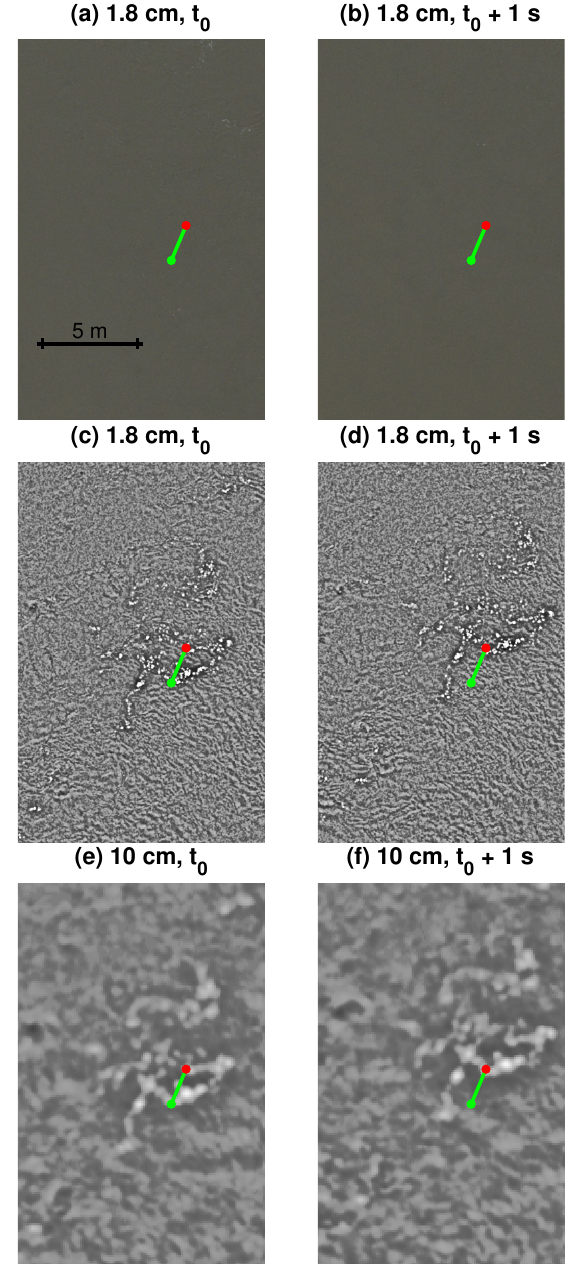
Figure 7. Importance of image preprocessing and spatial resolution. Green point represents location of the tracked feature at time 0 and red point indicates the location of the same feature in the next frame in the image sequence, acquired 1 s later. Measured displacement is 1.99